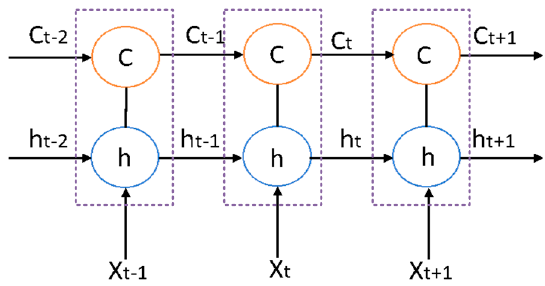
Figure 3. Network structure unfolded in time.